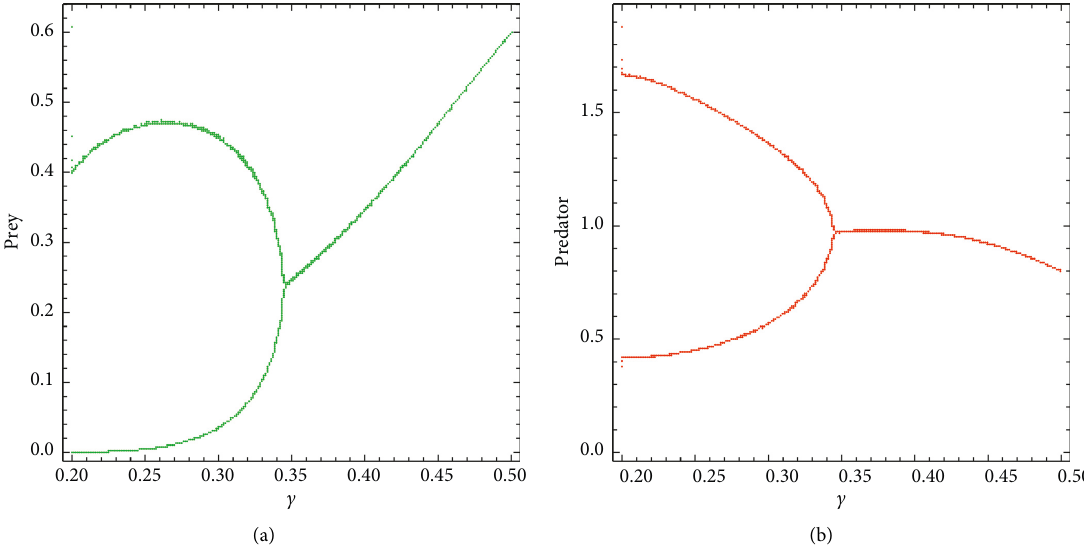
� 0 . 2, δ � 0 . 2, and c � 0 . 34. 1